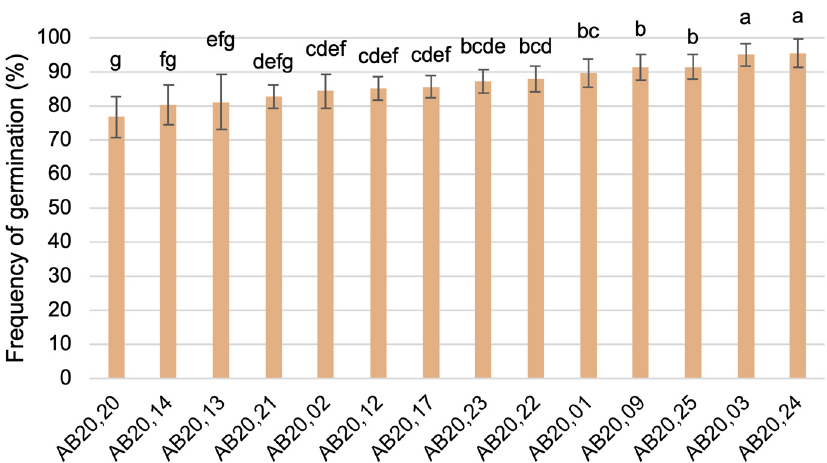
Figure 6. Data on in vitro germination frequency of seeds obtained from the programmed crosses after bT2 treatment. Results are expressed as the (number of germinated seeds/total treated seeds) × 100 at 30 days after treatment. One-way ANOVA was used to analyze the data. Different letters show significant differences at p < 0.05 by Duncan’s test ± standard deviation (n = 250).